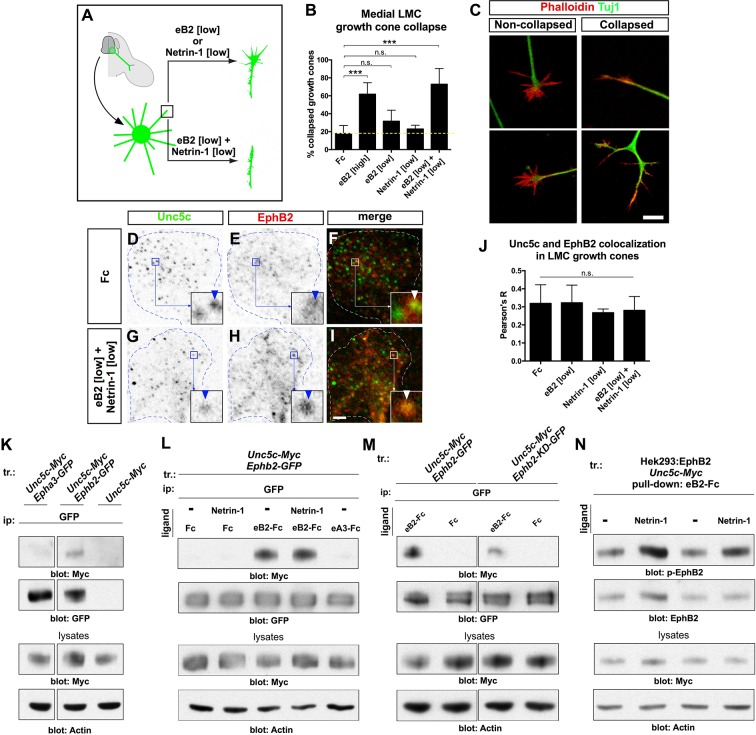
Ligand-dependent and signal-dependent EphB2-Unc5c complex formation and EphB2 phosphorylation.(A) Medial LMC neuron explant growth cone collapse assay scheme. (B) Percentage of collapsed e[Isl1]::GFP medial LMC growth cones following 30 min exposure to Fc (10 μg/ml), eB2-Fc (high: 10 μg/ml; low: 1 μg/ml), Netrin-1 (300 ng/ml) or Netrin-1 and eB2-Fc (300 ng/ml and 1 μg/ml). Significance computed using Fisher’s exact test. (C) Examples of growth cones labeled with Tuj1 (green) and phalloidin (red). (D–I) Unc5c and EphB2 protein localization in non-permeabilized LMC growth cones treated with Fc or eB2 and Netrin-1 for 15 min. Individual channels are inverted. All treatments result in same receptor protein signal levels (eB2 and Netrin-1 images are in Figure 6—figure supplement 1). Receptor clusters are depicted in insets, arrowheads: Unc5c and EphB2 co-localization. (J) Pearson's R value as a measure of surface Unc5c and EphB2 co-localization in LMC growth cones. Co-localization levels are higher than expected by chance, as demonstrated by Costes’ shuffled image P-value calculations (Figure 6—figure supplement 1). Ligand treatment does not increase the levels of receptor co-localization observed (p=0.7940, one-way analysis of variance (ANOVA) and Tukey's multiple comparisons test; N = 3; n ≥ 33 growth cones per treatment). (K) Unc5c and EphB2 receptor interactions. Unc5c-Myc was co-immunoprecipitated with EphB2-GFP but not with EphA3-GFP in transfected HEK-293 cells. All samples shown were run in same gel. (L) Unc5c-EphB2 interaction is selectively enhanced by 15 min incubation with eB2-Fc (1.5 μg/ml) or eB2-Fc+Netrin-1 (1.5 μg/ml +250ng/ml) but not with Netrin-1 (250 ng/ml), Fc (1.5 μg/ml), or ephrin-A3-Fc (1.5 μg/ml) prior to lysates preparation. Fc fusion proteins were pre-clustered by incubating them with anti-human or anti-mouse Ig for 1 hr at 4°C. For quantifications see Figure 6—figure supplement 1N. (M) Comparison of Unc5c interactions with wild-type or kinase-dead EphB2. Unc5c-Myc/EphB2-GFP interaction is blocked when a single point mutation is introduced in EphB2-GFP abolishing its kinase function (EphB2-KD-GFP, Dalva et al., 2000). For quantifications see Figure 6—figure supplement 1O. All samples shown were run in same gel. (N) P-EphB2 levels are increased upon stimulation with Netrin-1+eB2-Fc compared with eB2-Fc alone. p-EphB2 was developed first, followed by stripping of the membrane and re-blotting with anti-EphB2 antibody. Two replicate comparisons are shown; one sample t-test; p<0.02, N=10 comparisons, 4 experiments. eB2, ephrin-B2-Fc; ip, immunoprecipitation; LMC, lateral motor column; tr, transfection. All error bars = SD; *** = p<0.001; n.s. = not significant; scale bars: (C) 10 μm; (D–I) 2 μm. All values (mean ± SD) can be found in Supplementary file 1B.